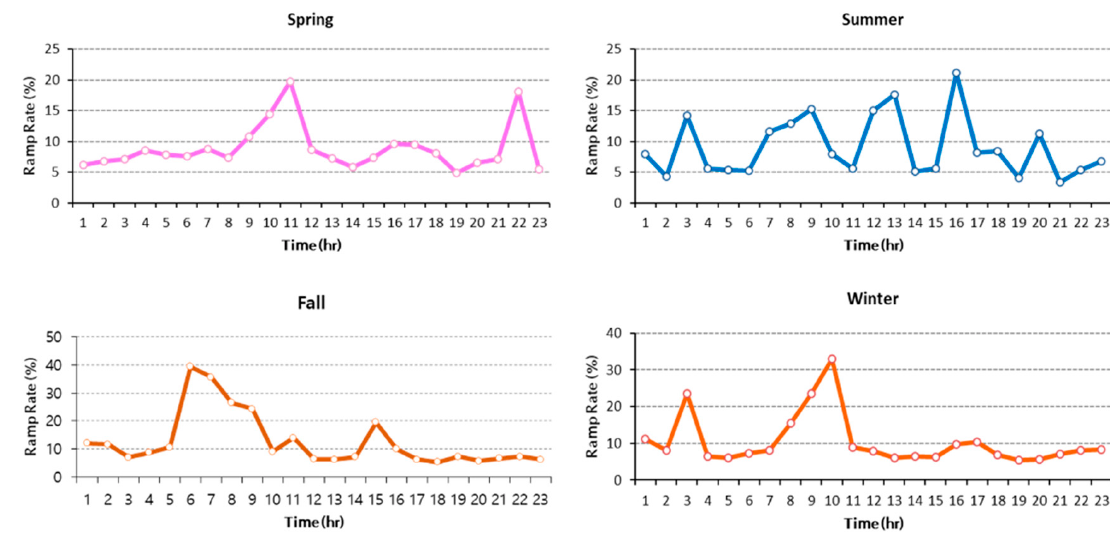
Figure 2. Seasonal ramp rates of 2018 for spring, summer, fall and winter.